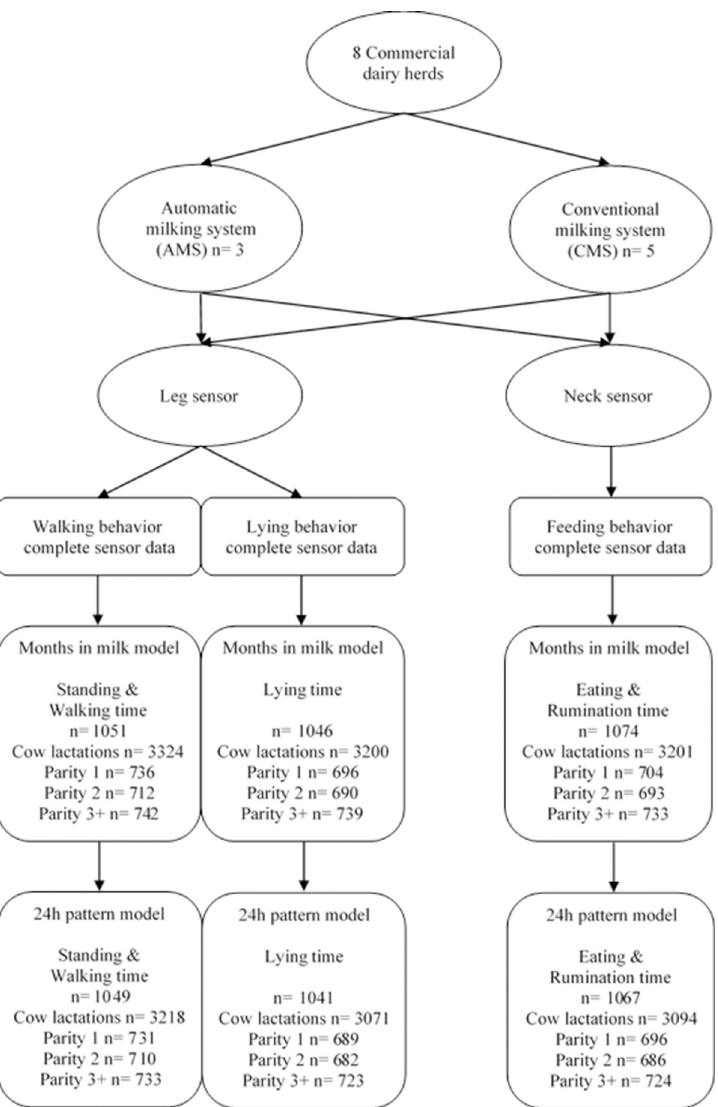
Fig 1. Distribution of all cows used in this study equipped with both leg and neck sensors per type of farm (AMS = automatic milking system, CMS = conventional milking system) per statistical model (months in milk model and 24h pattern